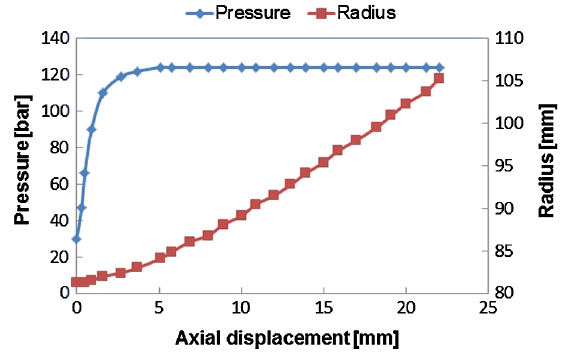
FIG. 20. DESY calibration device for hydroformed